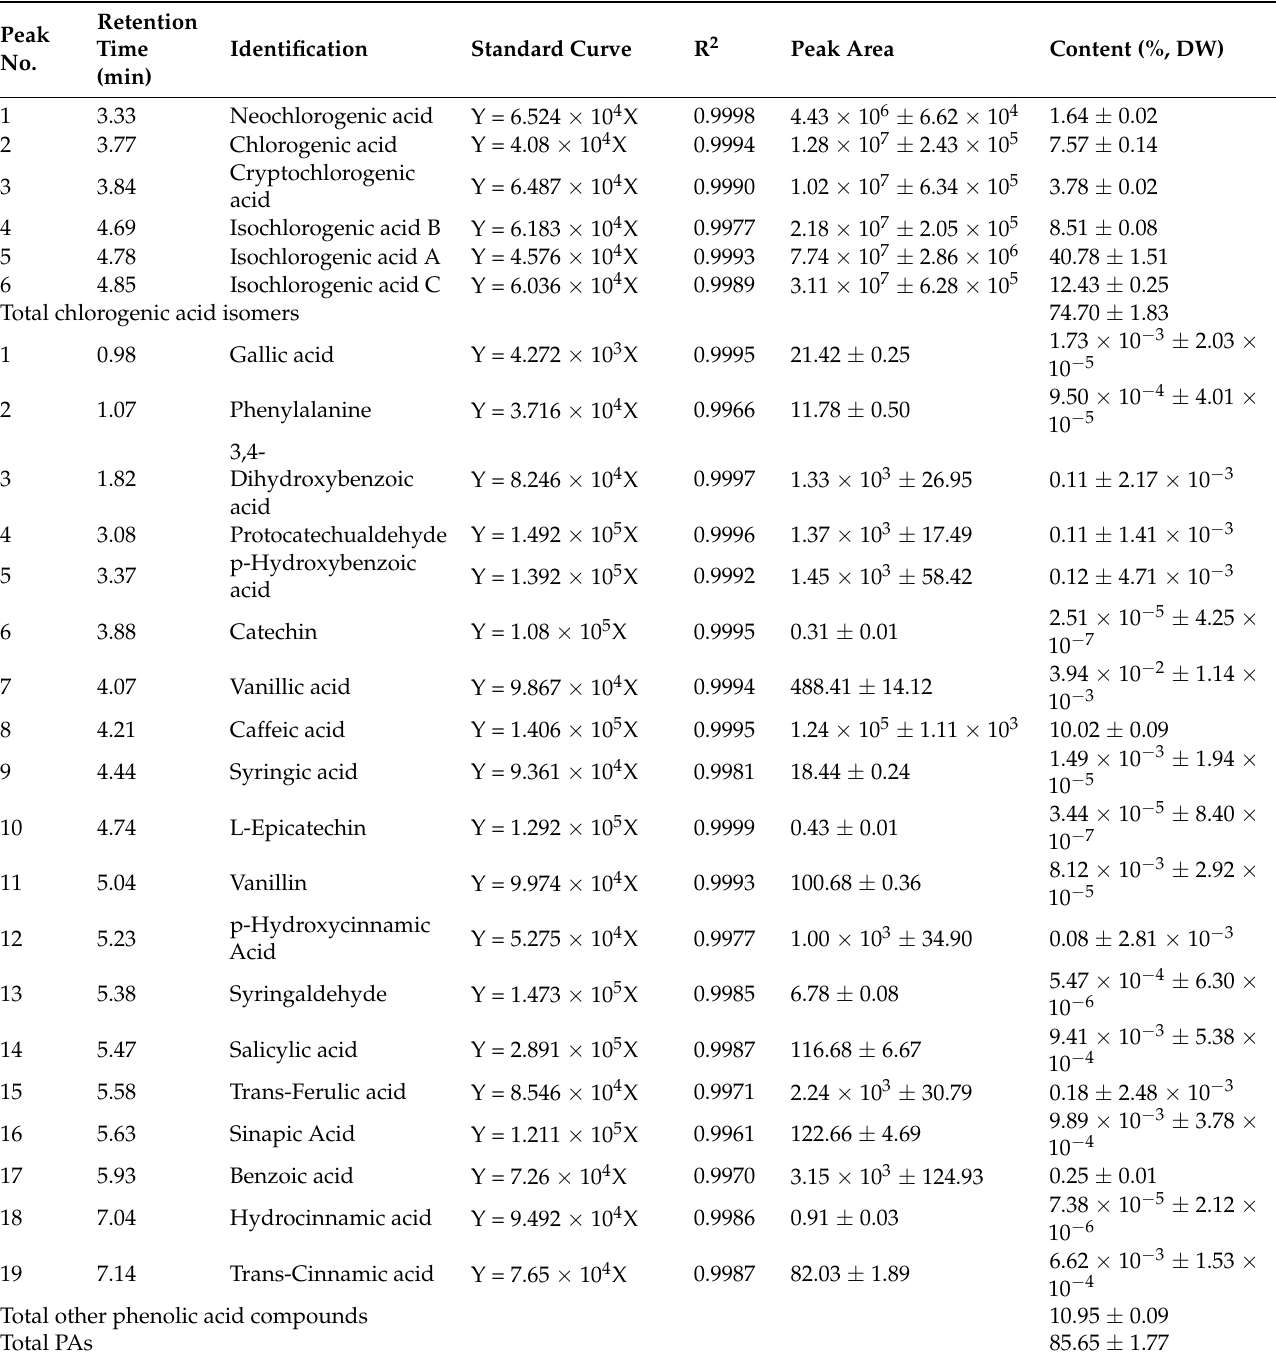
Table 1. Quantitated PAs from SPLPAs extract. Results expressed as mean ± standard deviation ( n =